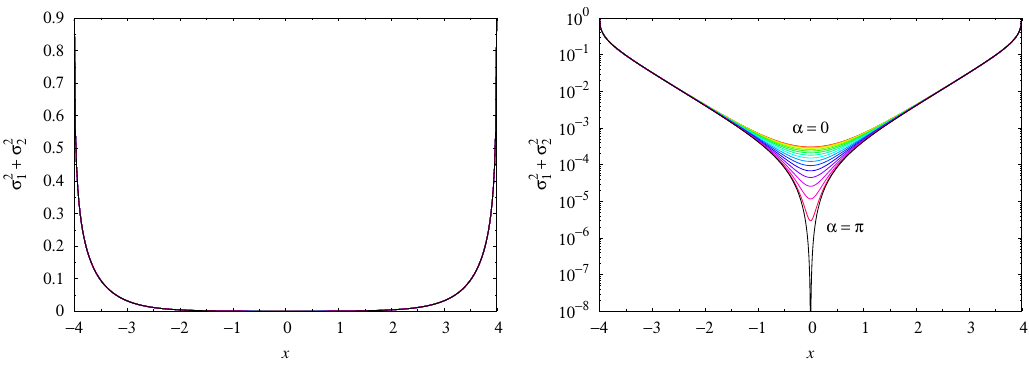
Figure 16. The same as (cid:12)gure 3 but for L =